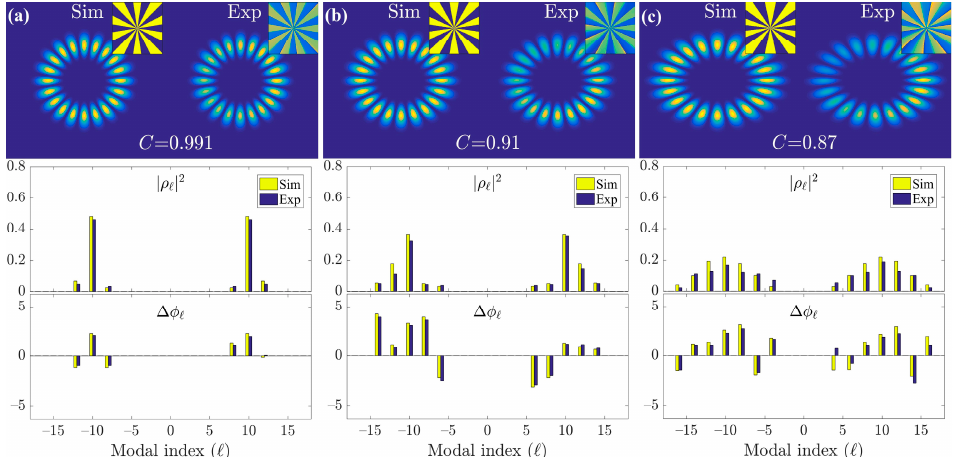
Figure 4. Theoretical simulations and experimental reconstructions of light mode and phase distributions and matched OAM power spectra | ρ l | 2 and phase spectra Δ φ l of superimposed OAM-carried light modes with tilt angles of ( a ) 15°, ( b ) 30° and ( c ) 45°, respectively. C denotes the 2D correlation coe ffi cient between simulated and reconstructed light modes.